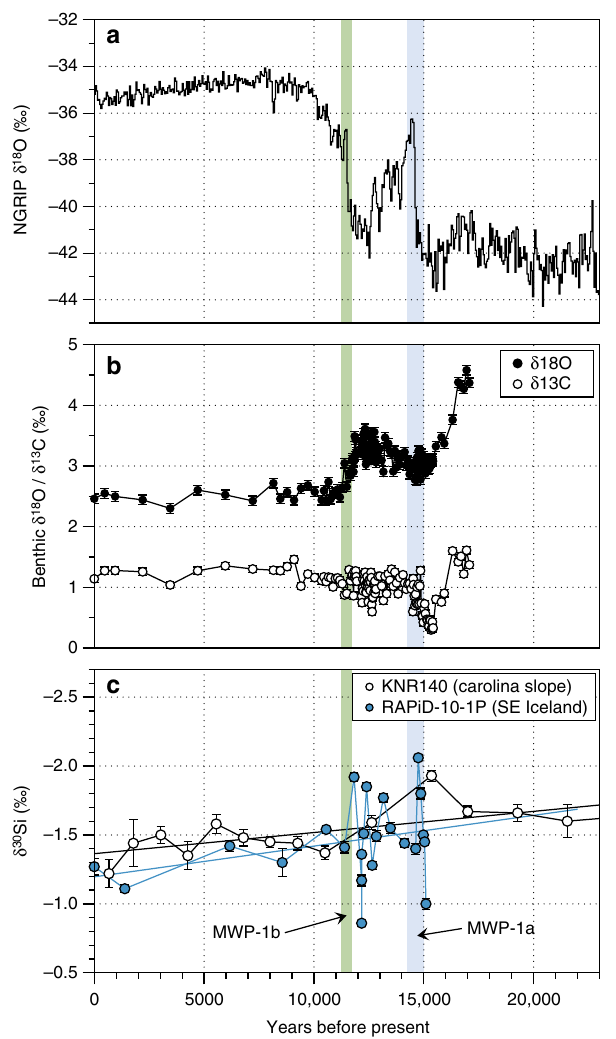
Fig. 6 Si isotope core records from deep-sea sponge spicules and other palaeo-data. a Greenland NGRIP ice core oxygen isotope record 85 , b benthic δ 18 O and δ 13 C record from Cibicidoides in the RAPiD-10-1P core (SE Iceland) 62 , and c Si isotope record from sponge spicules for the RAPiD-10- 1P core (blue) and the lower resolution KNR140 core for comparison (white; Carolina Slope 8 ). The shaded regions indicate approximate timings of Meltwater Pulse event 1a (blue) and Meltwater Pulse event 1b